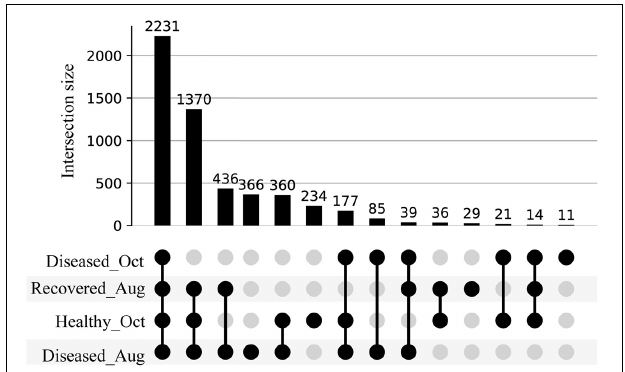
FIGURE 5 | UpSet plot of metabolite features detected in the healthy, diseased, and recovered samples arranged by decreasing frequency. The number on each bar represent total number of metabolite features in the corresponding intersection. For e.g., 2,231 represents the detection of a total of 2,231 metabolite features across all diseased, healthy, and recovered samples, whereas 1,370 represents the detection of a total of 1,370 metabolite features across diseased samples collected in August, healthy, and recovered